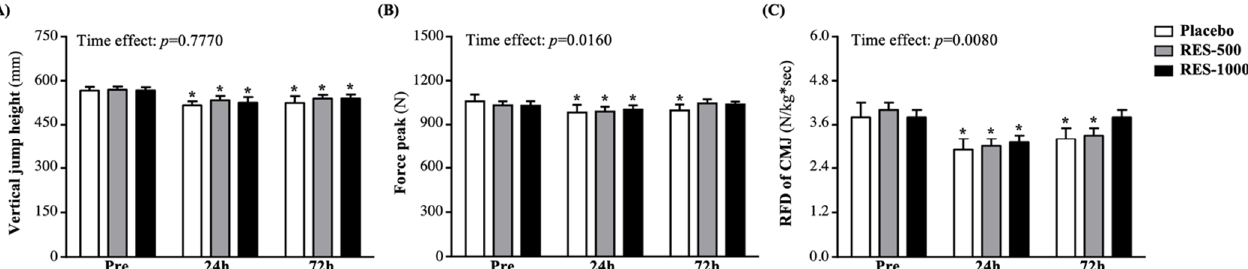
Figure 3. Effect of supplementation with RES on ( A ) vertical jump height, ( B ) force peak, and ( C ) RFD of CMJ. Data are presented by mean ± SEM. Administration effects were statistically analyzed with a paired Student’s t -test, * p < 0.05. RFD, rate of force development; CMJ, countermovement jump.